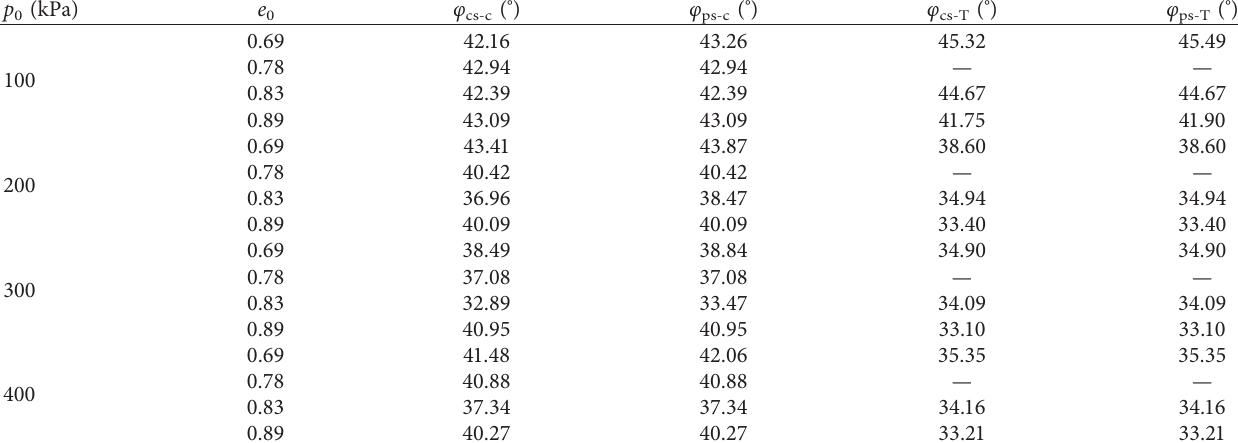
Table 5: Critical state friction angle and peak state friction angle of coral mud and Taizhou soil.